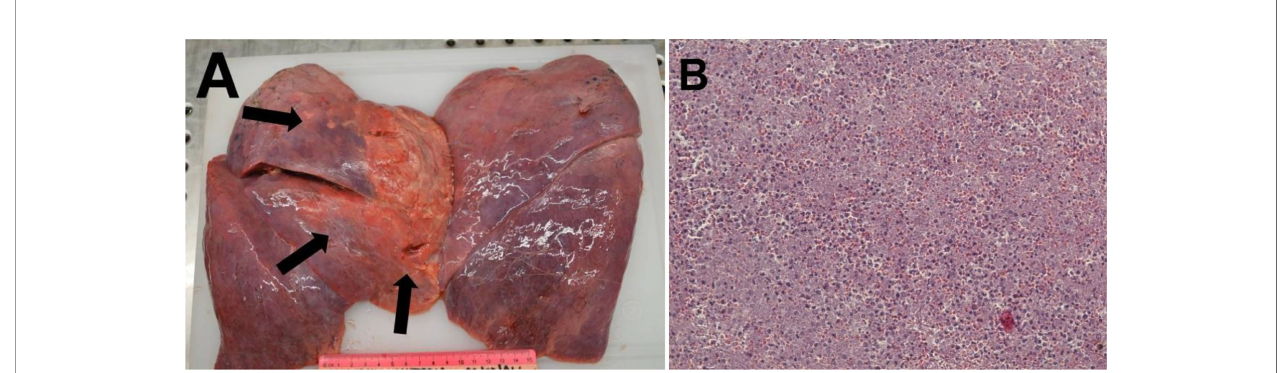
FIGURE 6 | (A) Macroscopic examination of the lung. Single thin arrows, surface of the right upper lobe with a yellow-white color. (B) Hematoxylin and eosin staining. The completely subverted parenchyma structure with hypoarated or hepatized-like tissue. The alveoli were fi lled with in fl ammatory cells, including lymphomonocytes and granulocytes. Red blood cell in fi ltration is also evident. Features of emphysema can be seen at the periphery of the section, with breaking of the alveolar walls and fusion of the